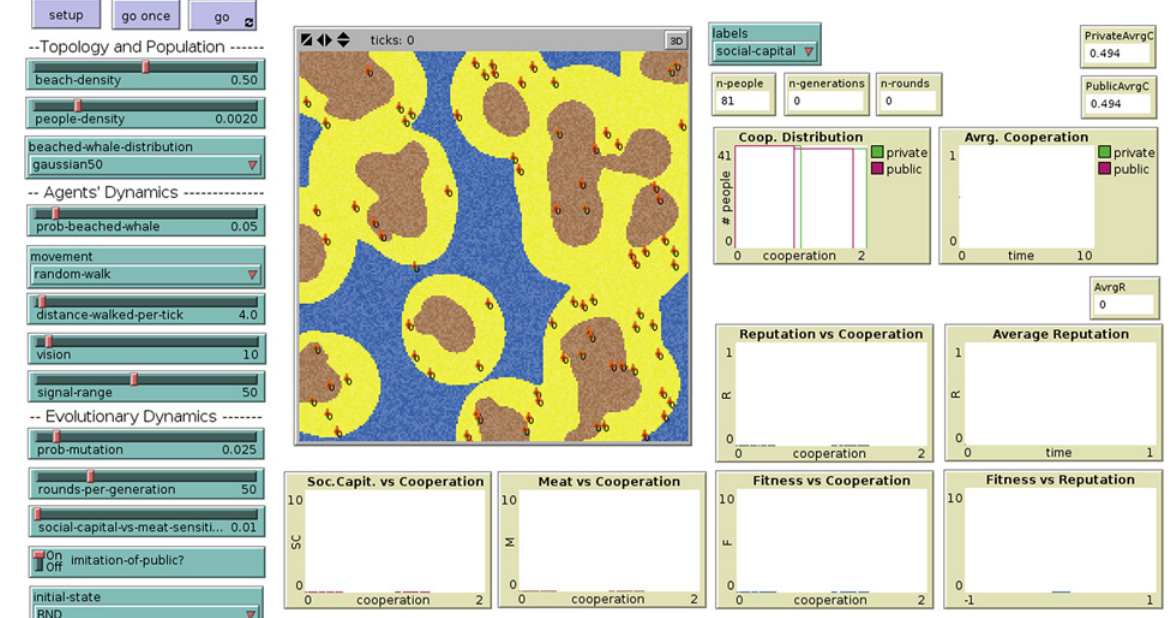
Fig 3. Interface of the model implementation in